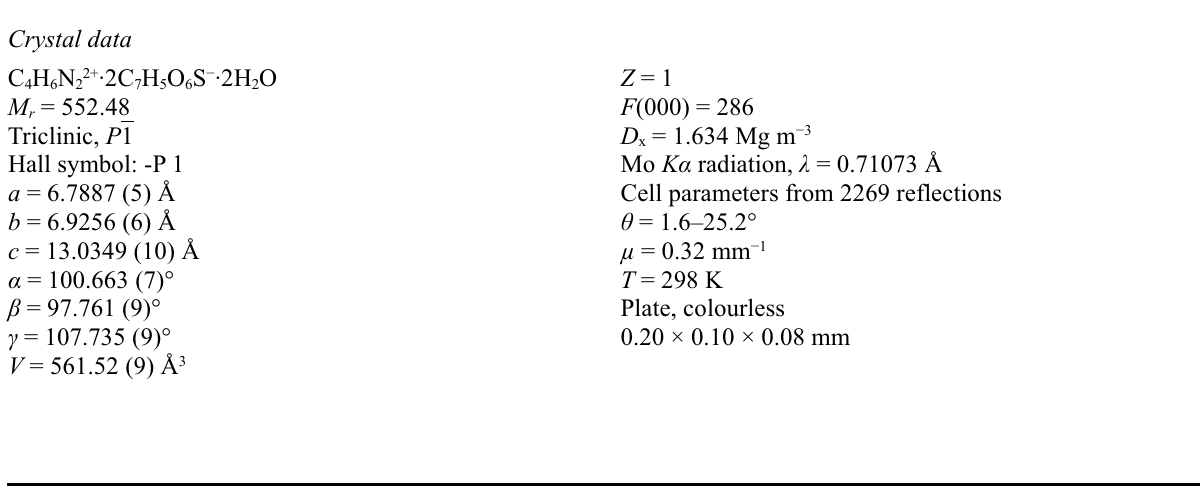
Excerpt from the crystal structure showing the formation of the two-dimensional layers running parallel to the [102] direction. Hydrogen bonds are shown as dashed lines. For the sake of clarity, H atoms not involved in the motif have been omitted from the